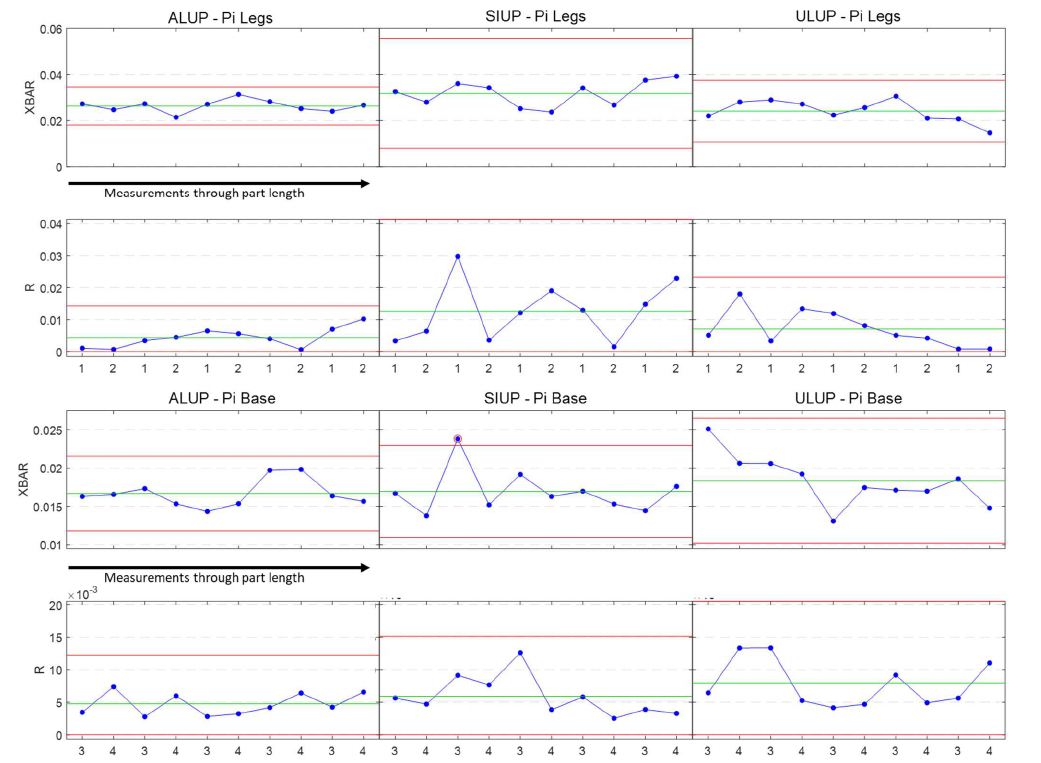
Figure 10. Control charts measuring change in crimp TT in flow-“up” parts (ALUP, SIUP, ULUP).